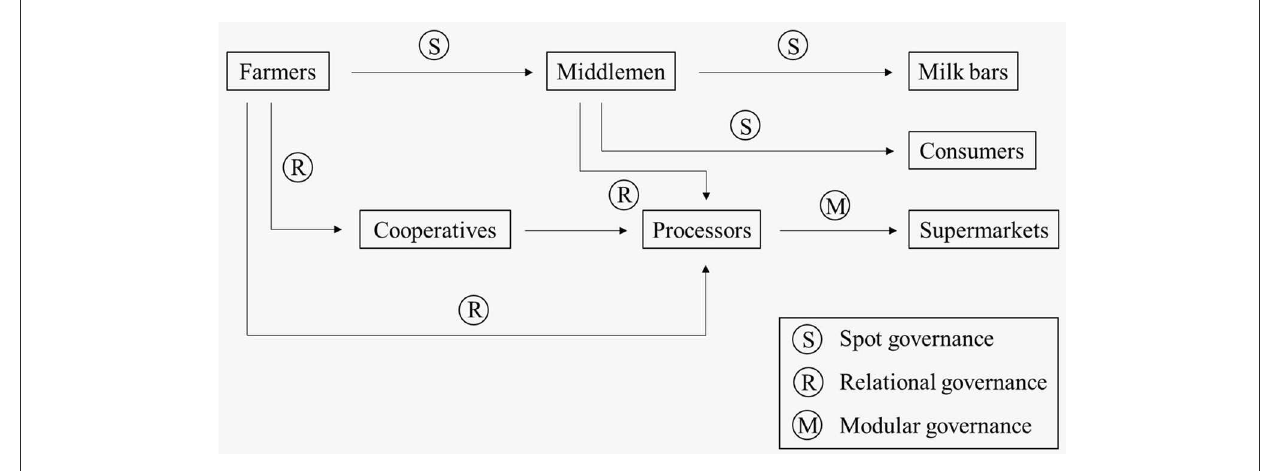
FIGURE3 Governance structures in the milk value chain in